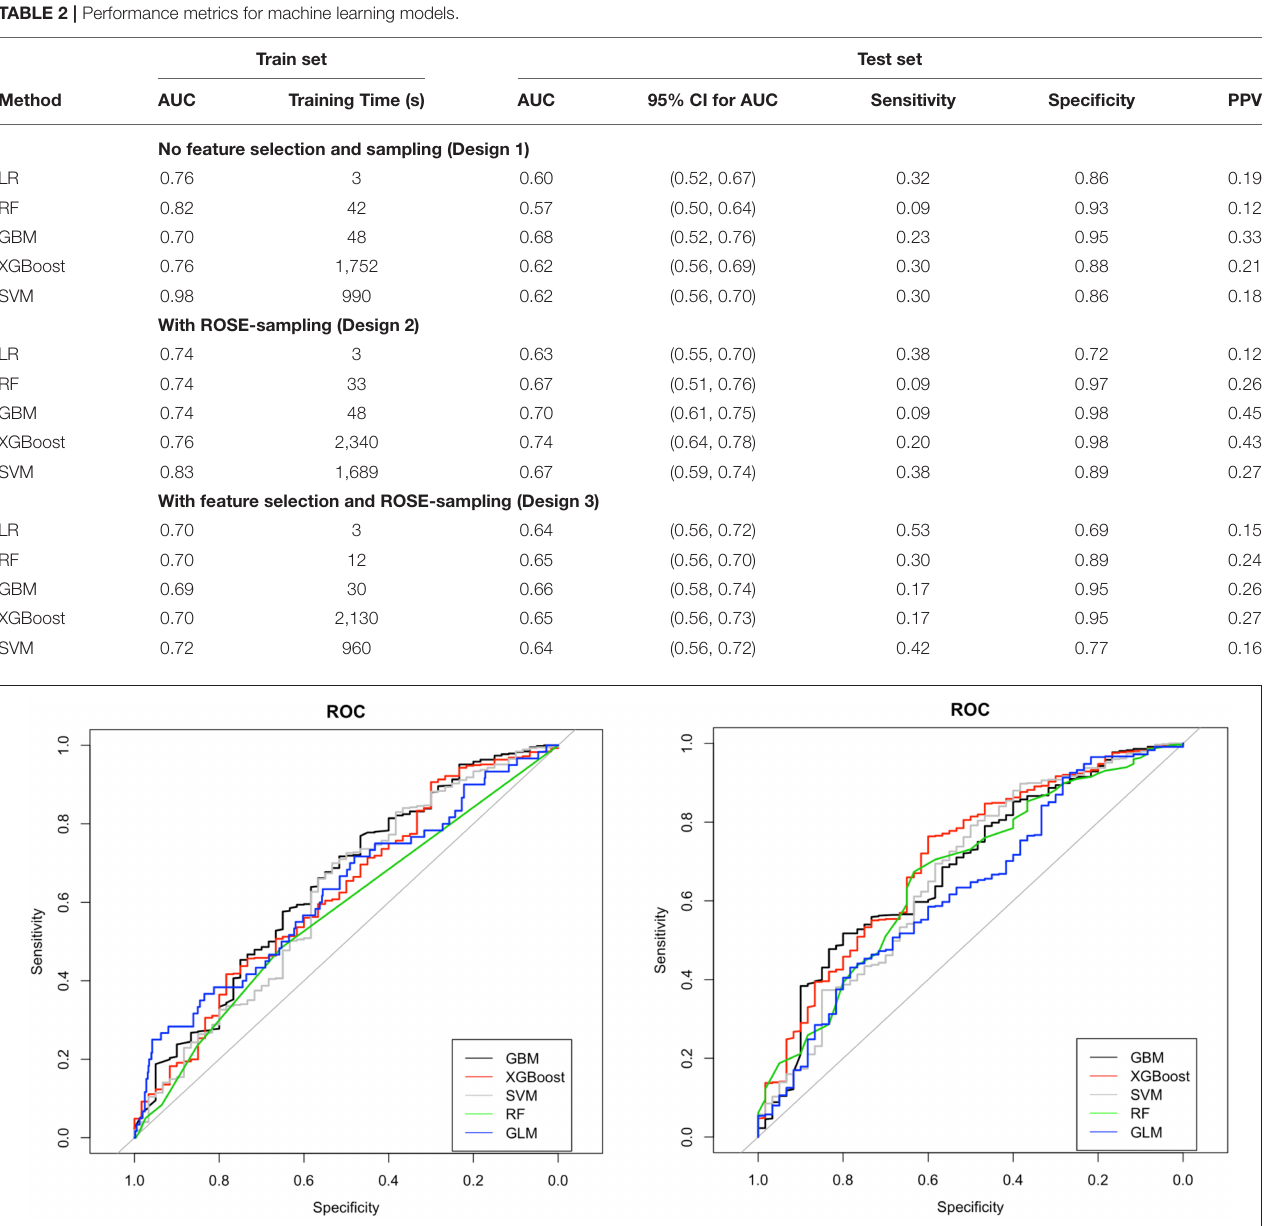
FIGURE 2 | ROC curves for machine learning models with (bottom) and without (top) ROSE-sampling. GBM, gradient boosting machine; XGBoost, extreme gradient boosting; SVM, support vector machines; RF, random forest; and GLM, generalized linear model with logit link which is logistic regression in our study.